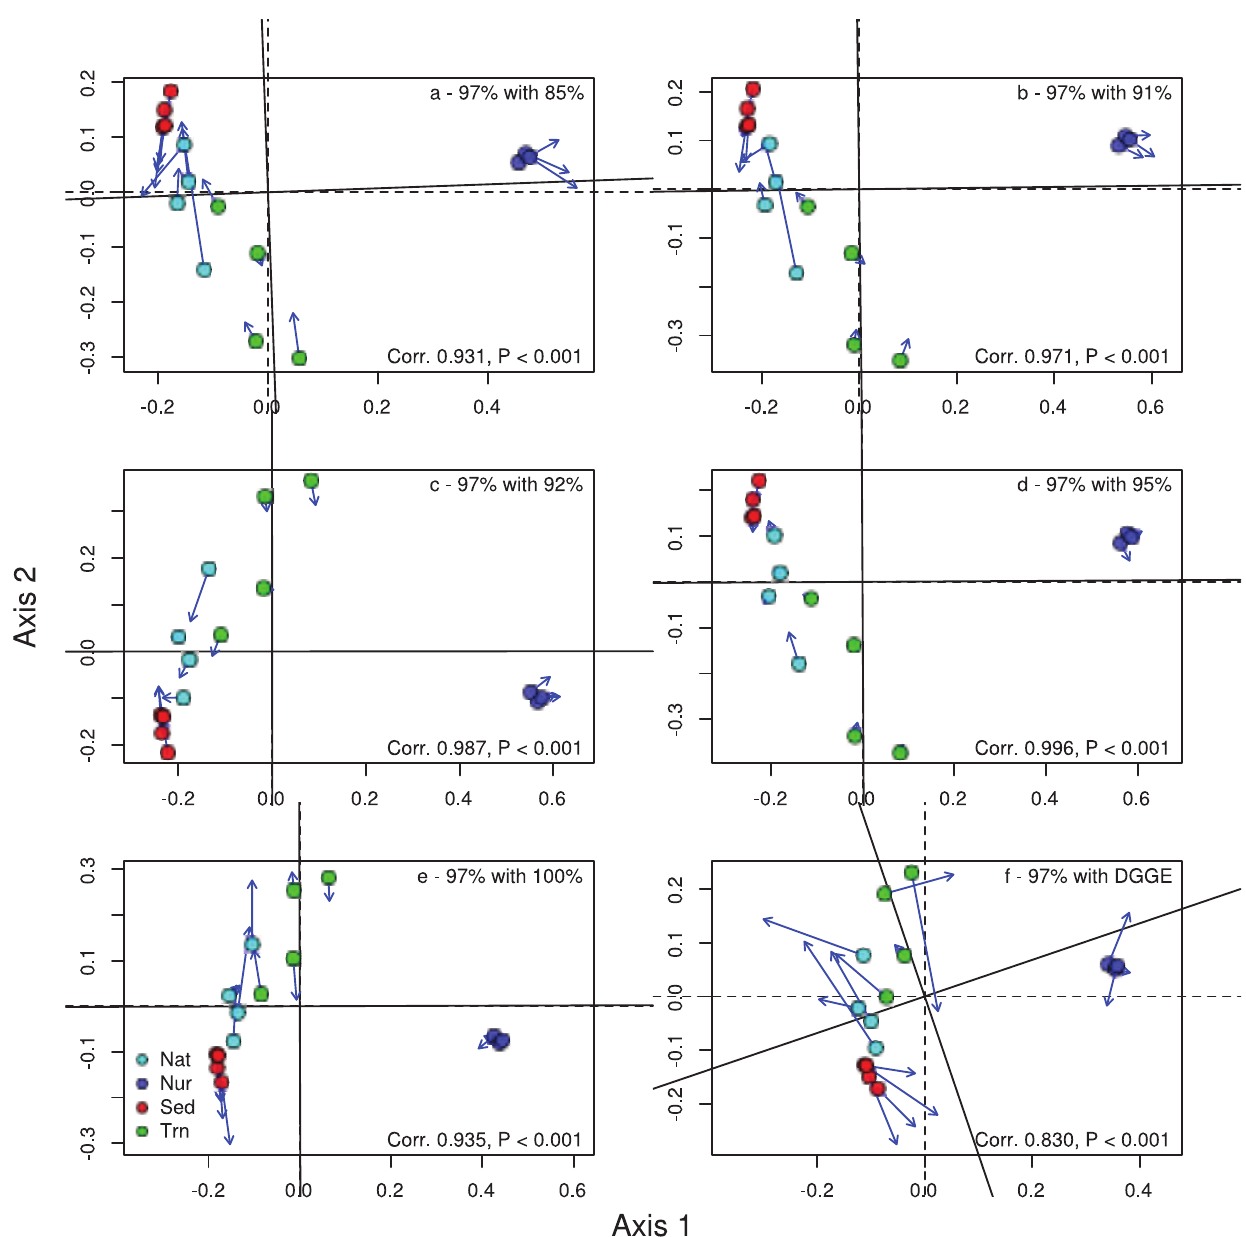
Figure 1. Ordination showing the first two PCO axes of the all bacteria analysis for a) 85% cut-off level with 97%, b) 91% cut-off level with 97%, c) 92% cut-off level with 97%, d) 95% cut-off level with 97%, e) 100% cut-off level and f) DGEE data with 97% cut- off level. The arrows in the ordination point to the target configuration, the actual symbols represent the rotated configuration, i.e., the ordination based on the 97% cut-off values. Correlation (Corr) and significance values are given in the lower right corner of each graph. Both target and original rotated axes are shown as crosshairs on the plot using unbroken and dashed lines.